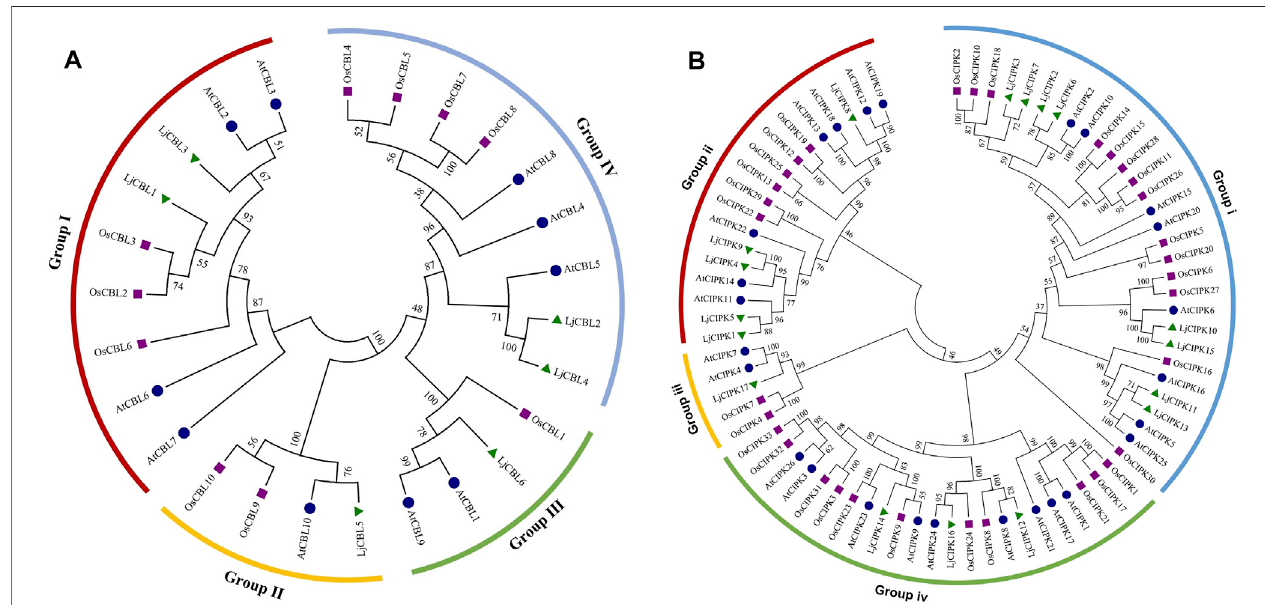
FIGURE 1 | Phylogenetic tree of the CBL (A) proteins and CIPK (B) proteins from Lonicera japonica (Lj), Arabidopsis thaliana (At), Oryza sativa (Os). The different colored arcs indicate different subgroups. Proteins from honeysuckle, Arabidopsis, and rice are denoted by green triangles, blue circles, and purple squares, respectively. Details of CBL and CIPK protein sequence from three species are listed in Supplementary Table S1 Sheet 1 .